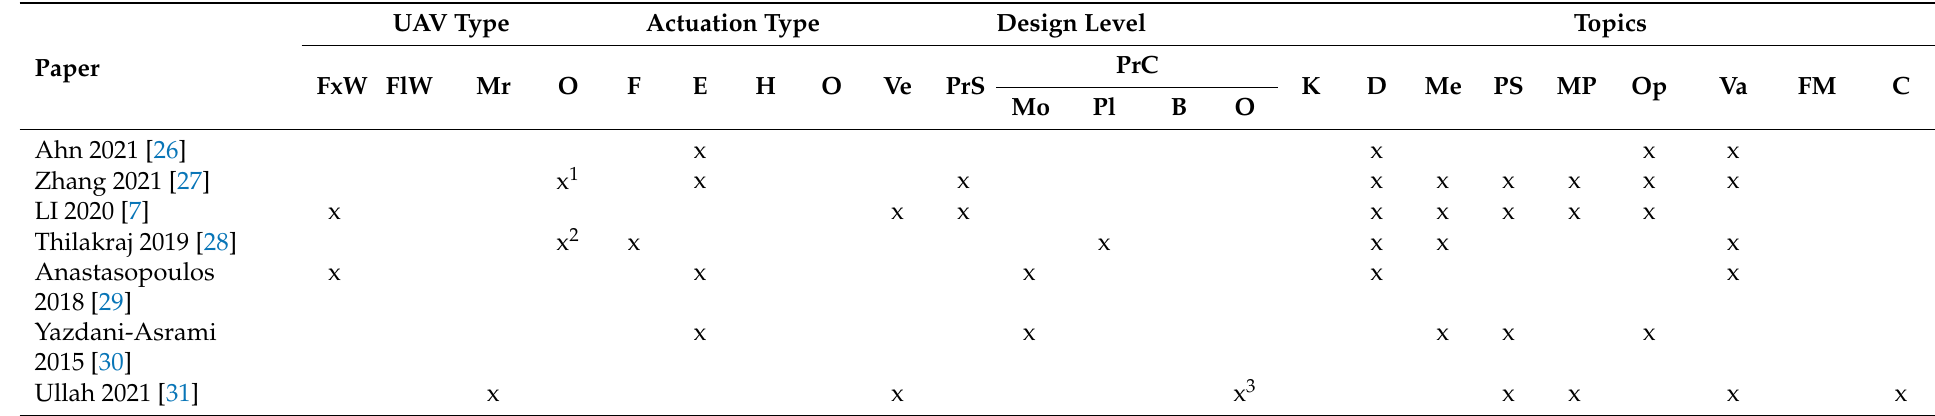
Table 4. Evaluation of the papers categorized in the optimization methods, according to the taxonomy referring to the paper